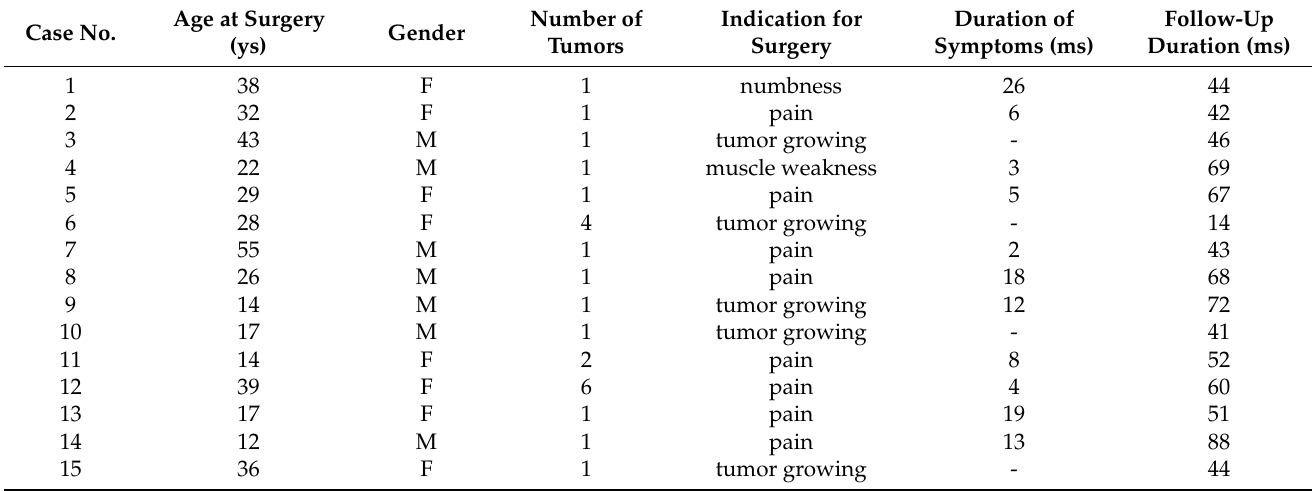
Table 1. Clinical features of 15 patients with nodular plexiform neurofibroma.